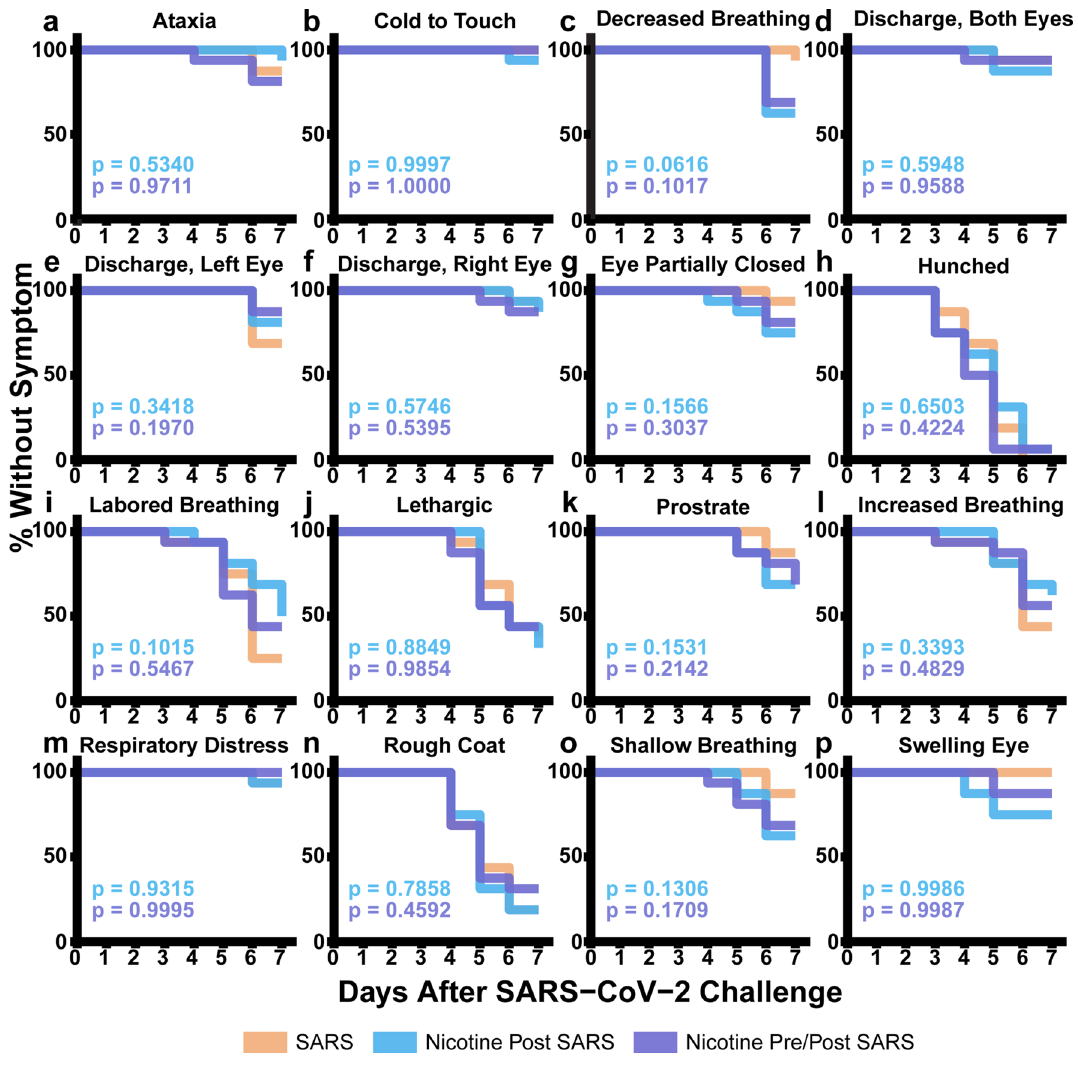
Figure 3. Onset of clinical symptoms. ( a – p ) Cox proportional hazard models comparing time of symptom appearance by treatment. The blue p-value compares survival curves between SARS and Nicotine Post SARS groups. The purple p -value compares survival curves between SARS and Nicotine Pre/Post SARS groups.